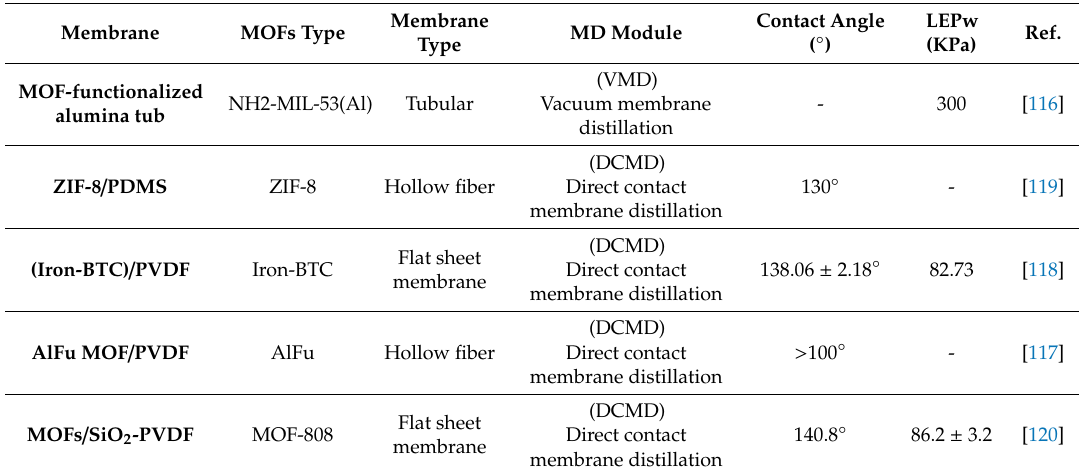
Table 4. A brief summary of MOFs-doped MD membranes used in various MD